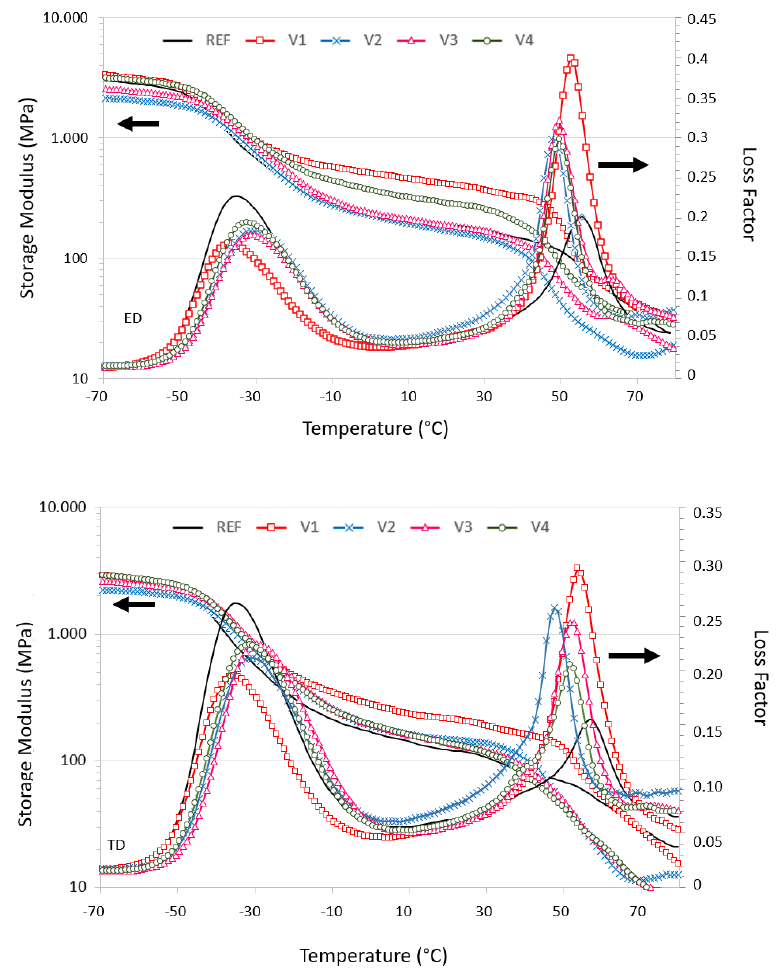
Figure 4. Comparison of temperature-dependent logarithmic storage moduli (log( E ’( T , ω = 1 Hz)) and loss factor ( tan δ ) of REF and V1 to V4 in the ED and TD directions at 23